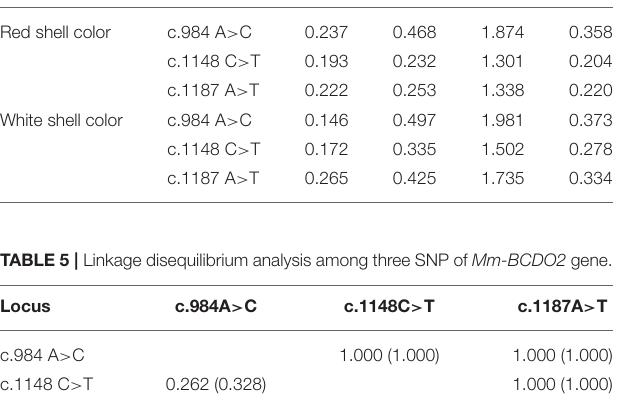
TABLE 4 | Polymorphic parameters of the SNP loci of Mm-BCDO2 gene. Strain Locus Ho He PIC